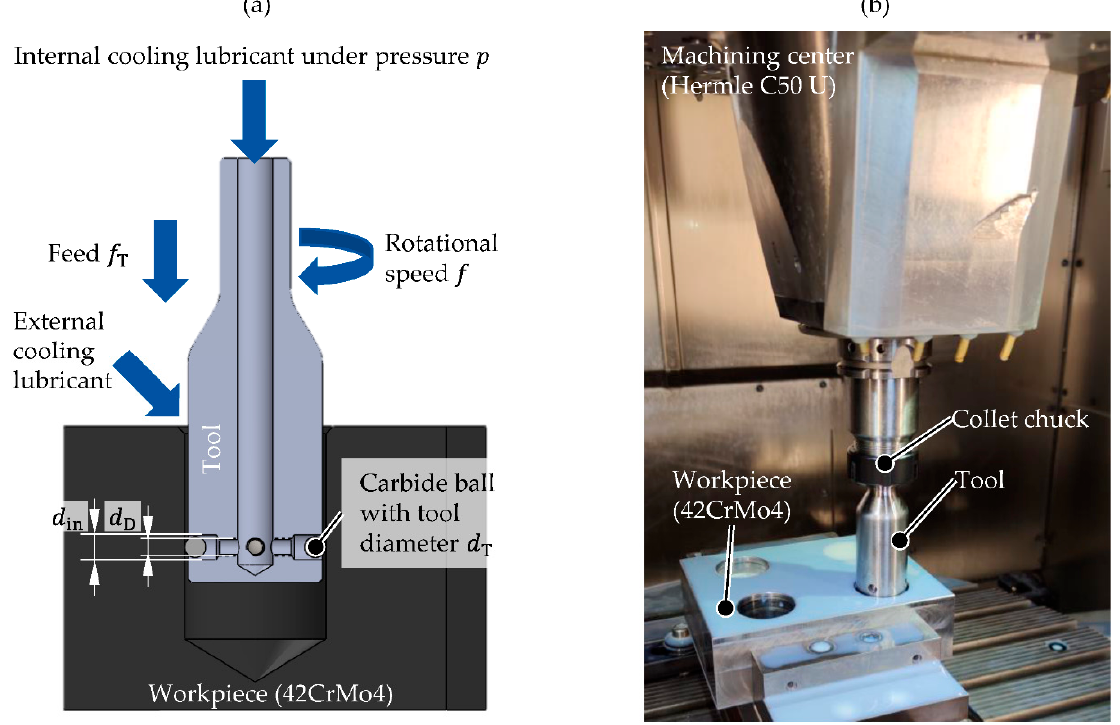
Figure 3. Schematic tool setup ( a ) and experimental setup in the machining center ( b ).